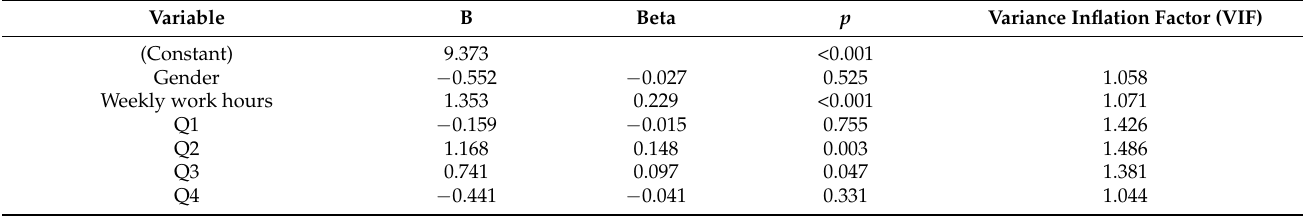
Table 9. Results of regression analysis of EE.